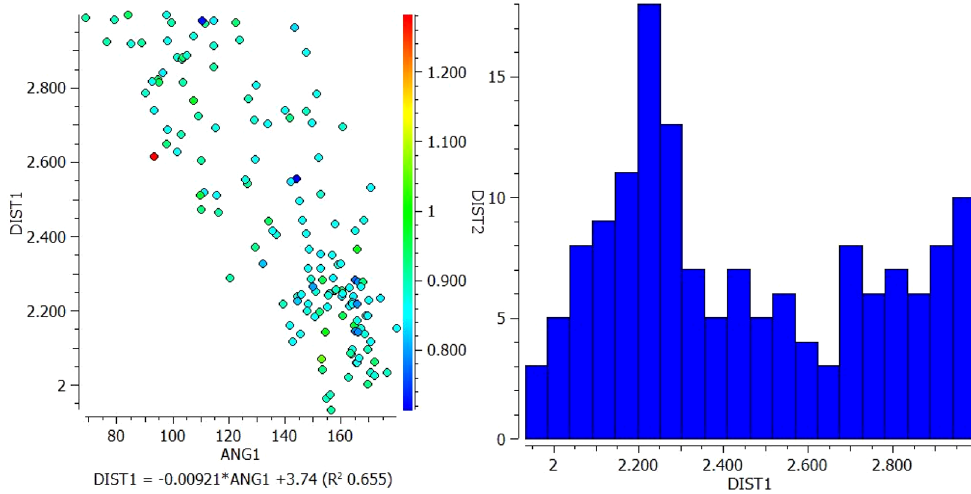
Figure 2. Scatterplot of DIST 1 versus ANG and histogram for O (16, 17) of VEM and NH18 of PE.